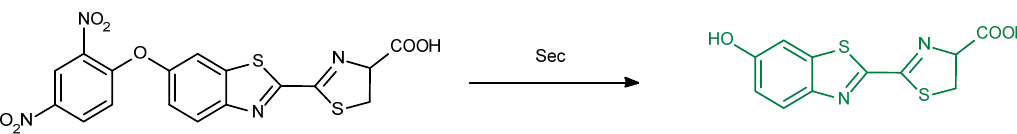
Figure 51. Bioluminescent probes initiated from the 2,4–dinitritro phenyl– group cleavage upon encountering selenocysteine by Zhang et al.